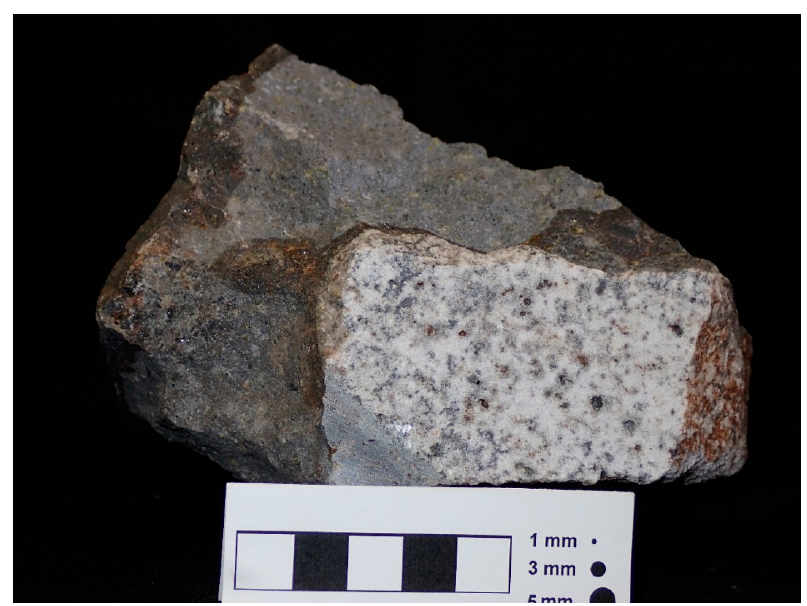
Figure 2. Granite xenolith in basalt from the Č amovce quarry.